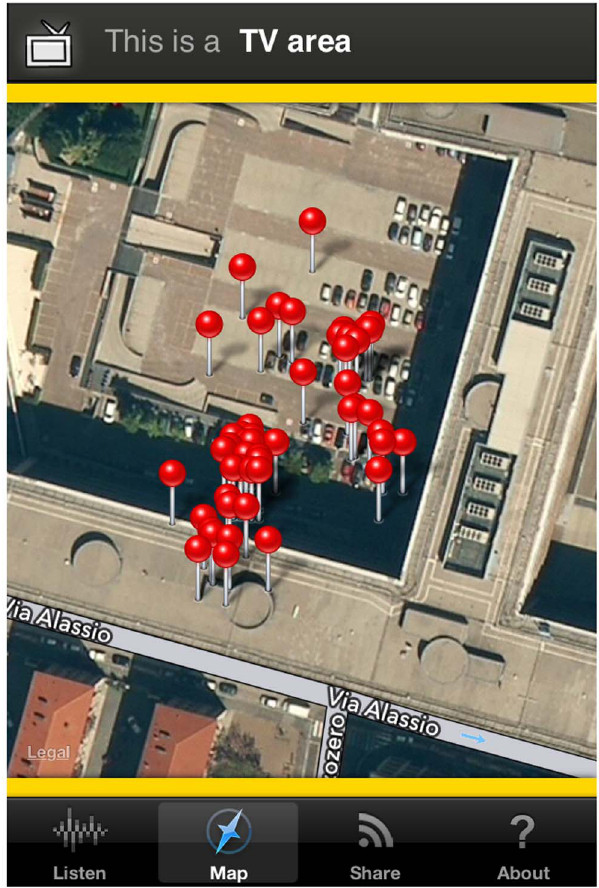
Figure 4. Map screen for WideNoise Plus mobile application.